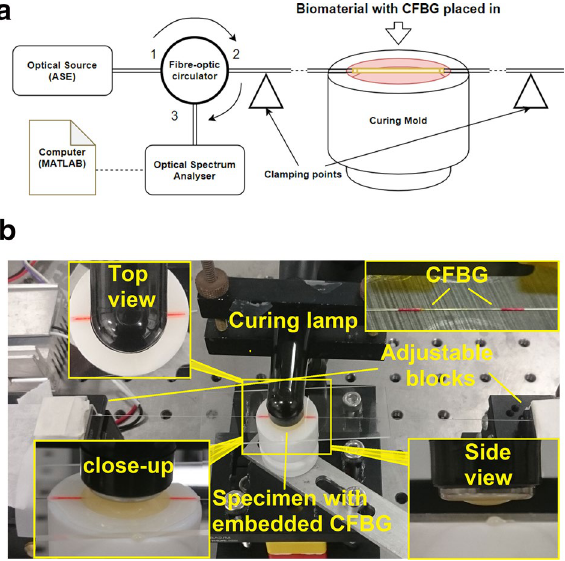
Figure 2. ( a ) Schematic experimental arrangement, ( b ) photograph of the